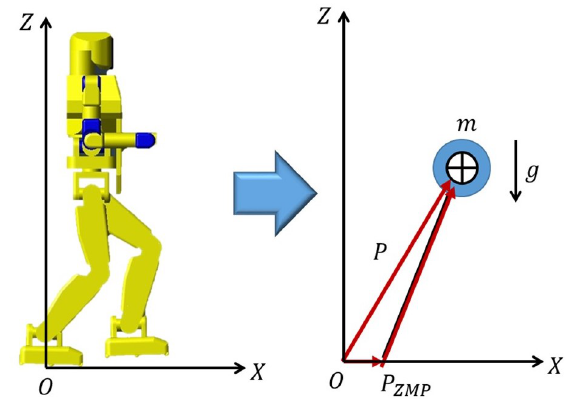
Figure 1. A simplified model of a biped robot in a support